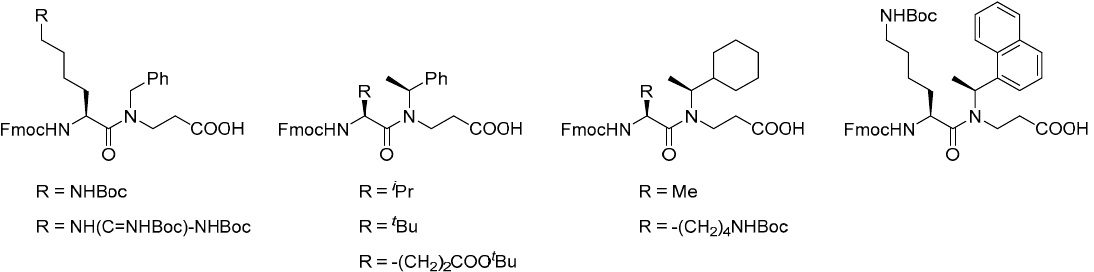
Figure 10. Dimeric building blocks obtained by solution-phase methods [214].